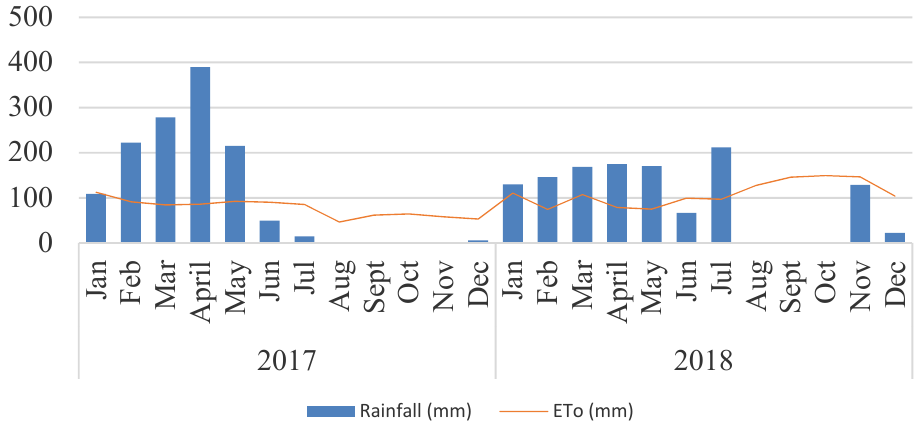
Figure 1. Monthly rainfall and Penman-Monteith/FAO reference evapotranspiration during the period of the experiment at the experimental site.